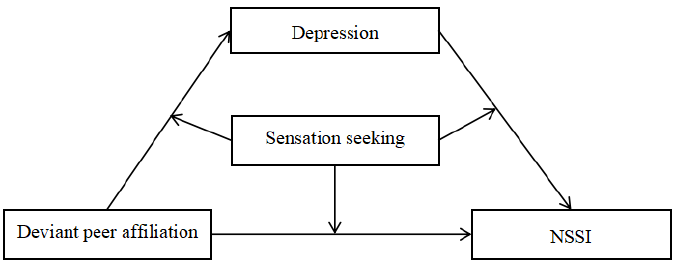
Figure 1. The proposed mediated moderation model. Note: NSS = non-suicidal self-injury.